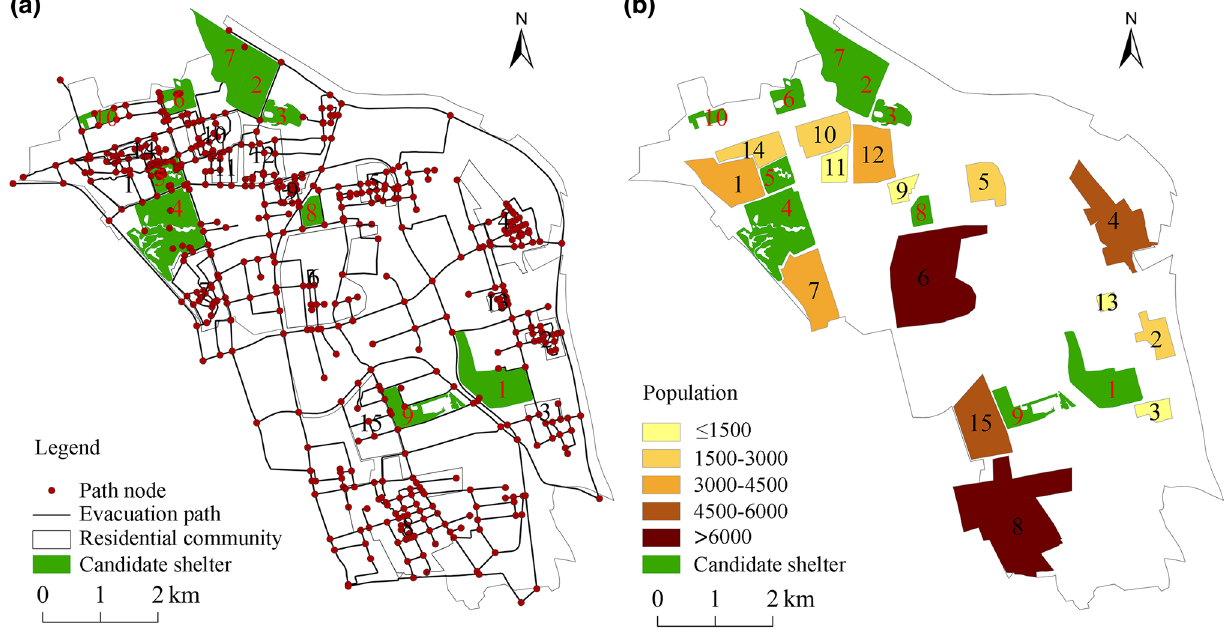
Fig. 1 Location of candidate shelters, communities, and possible evacuation routes ( a ), and community population ( b ) in Jinzhan Town, Chaoyang District, Beijing,